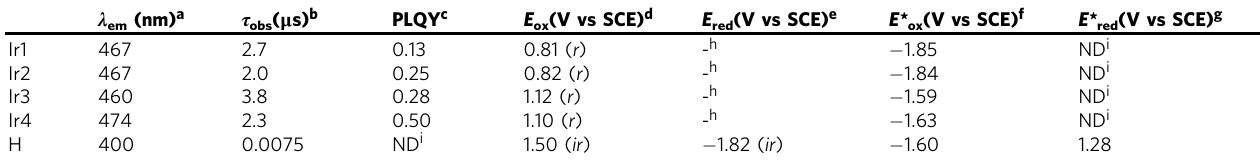
Table 1 Photophysical and electrochemical data for the Ir dopant and H host